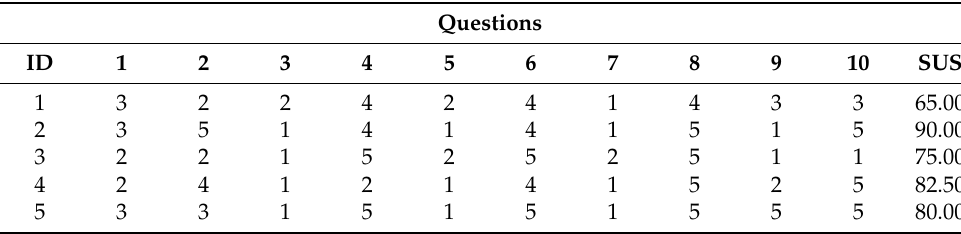
Table A3. SUS results for Ecuadorian